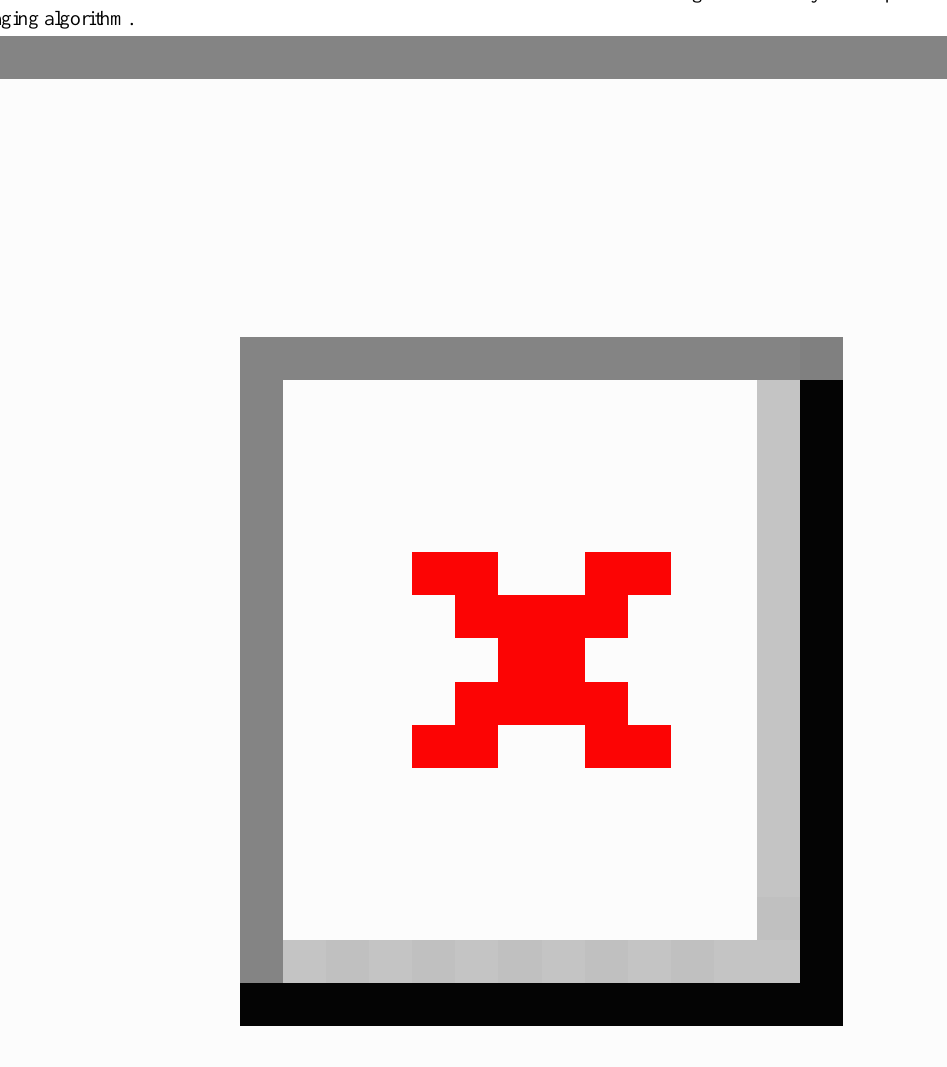
Figure 1. The association between Mini-Mental State Examination scores and dementia stages in Memory Clinic patients (N=109) staged according to ANN staging